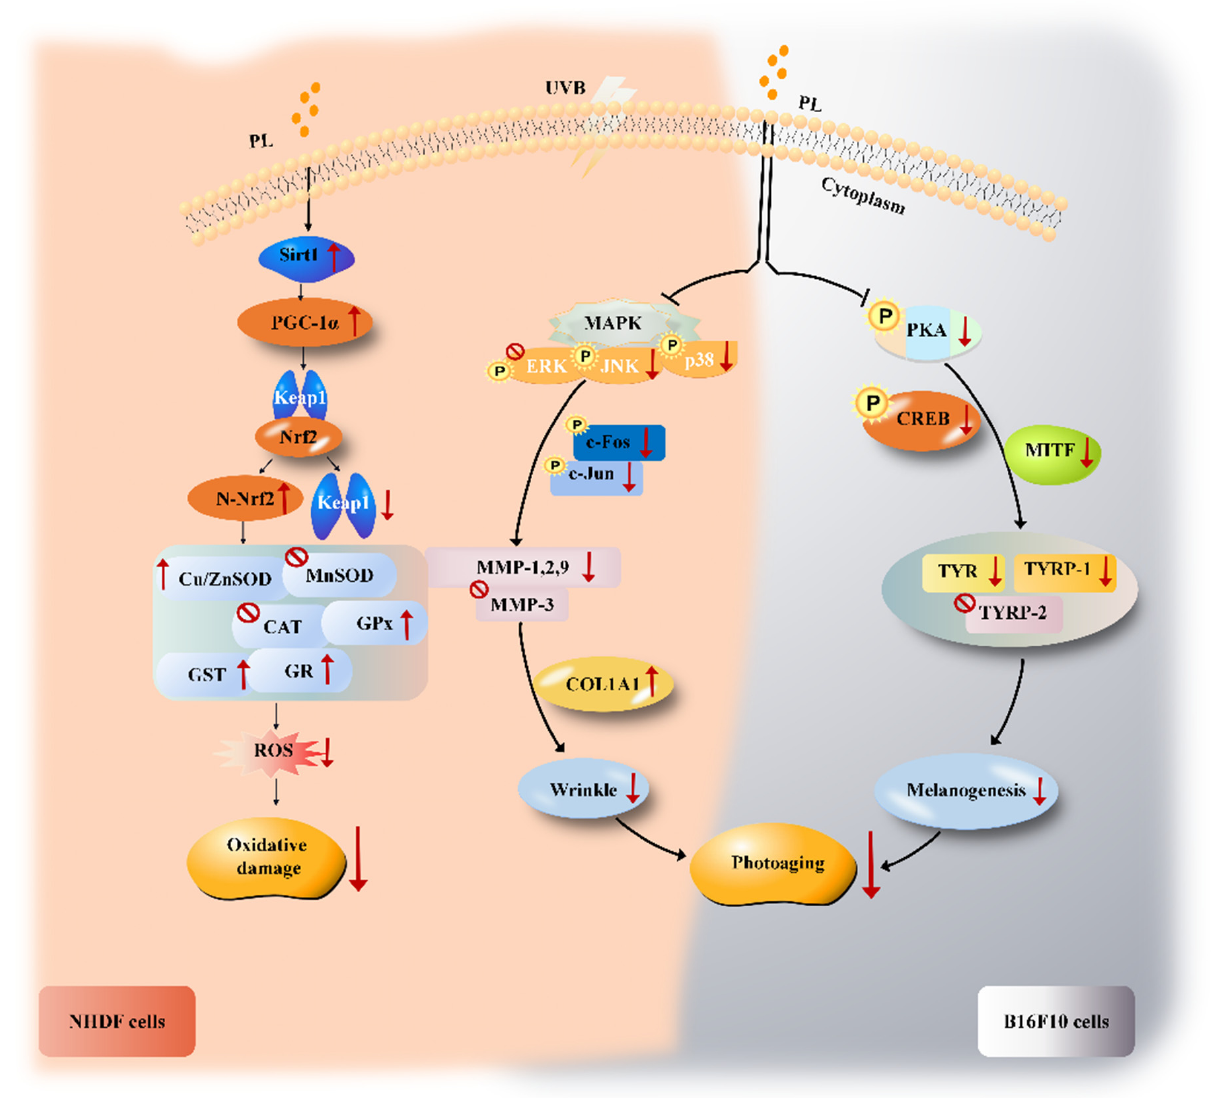
Figure 7. Proposed mechanism for the improvement of UVB-induced oxidative damage and pho- toaging by PL in NHDF and B16F10 cells. Arrows indicate positive regulation and T-bars indicate negative regulation.